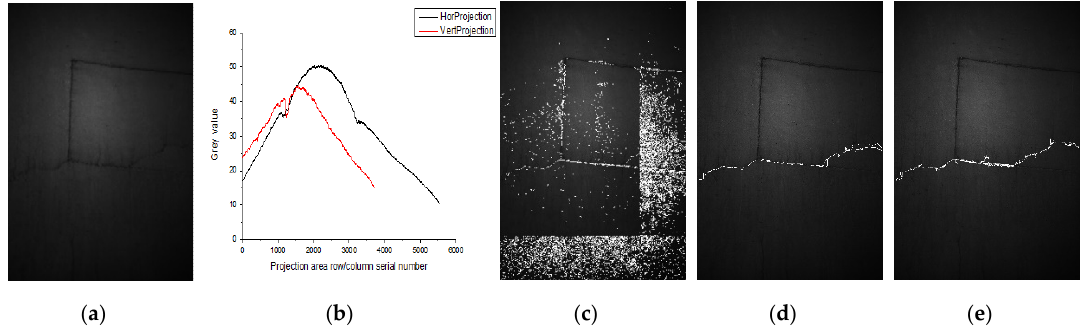
Figure 9. The crack detection result of image 2 by the algorithm in this paper ( a ) image 2; ( b ) gray